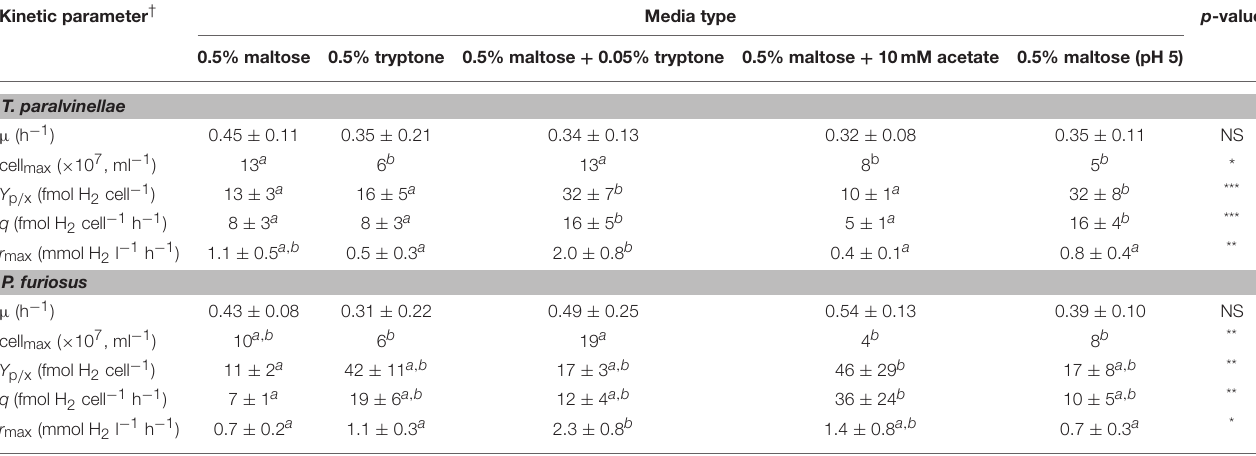
TABLE 1 | T. paralvinellae and P. furiosus kinetic parameters. Kinetic parameter †